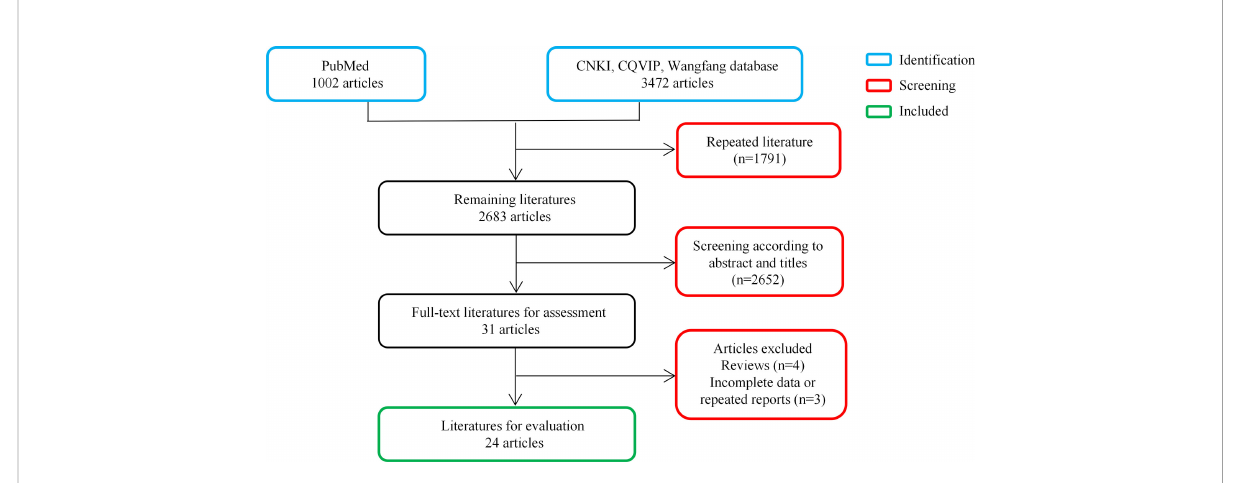
FIGURE 2 Flow diagram for selection of articles.